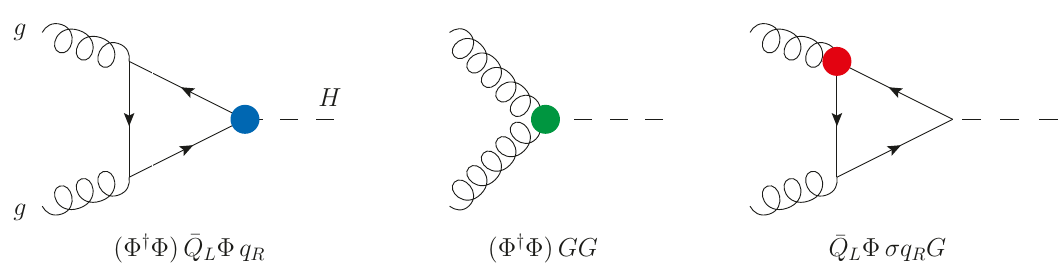
Figure 1 . Representative diagrams contributing to gluon-fusion amplitudes with one insertion of the three relevant operators. Heavy quarks, b or t , provide the leading contributions to the (cid:12)rst and third amplitudes. Note that for chromomagnetic operator, (cid:22) Q L (cid:8) (cid:27)q R G , a diagram featuring the four point gluon-quark-quark-Higgs interaction is also present (not